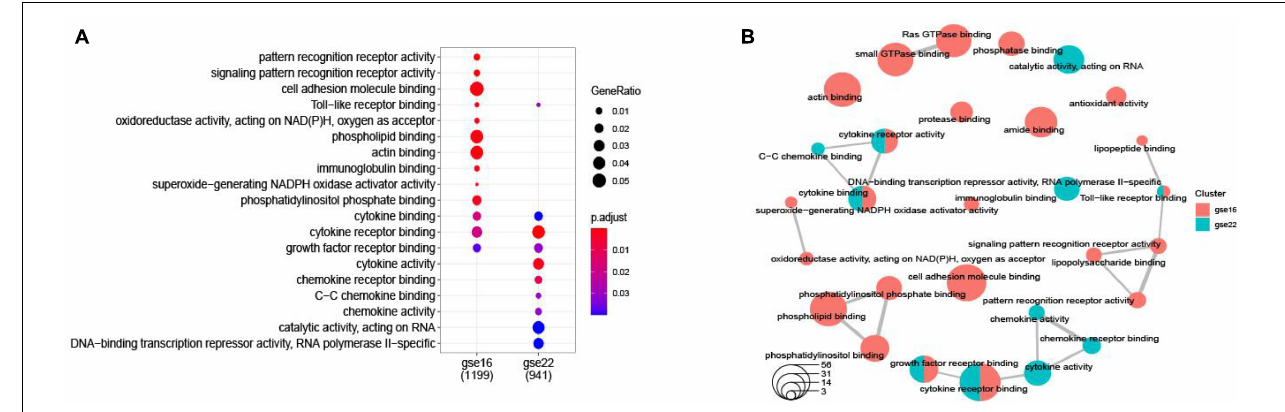
FIGURE 4 | (A) The protein-protein interaction network consisted by integrating the differentially expressed genes in two datasets. There are 1,460 relational pairs and 821 nodes in the network. (B) The various statistical indicators in the PPI network shown in (A) .